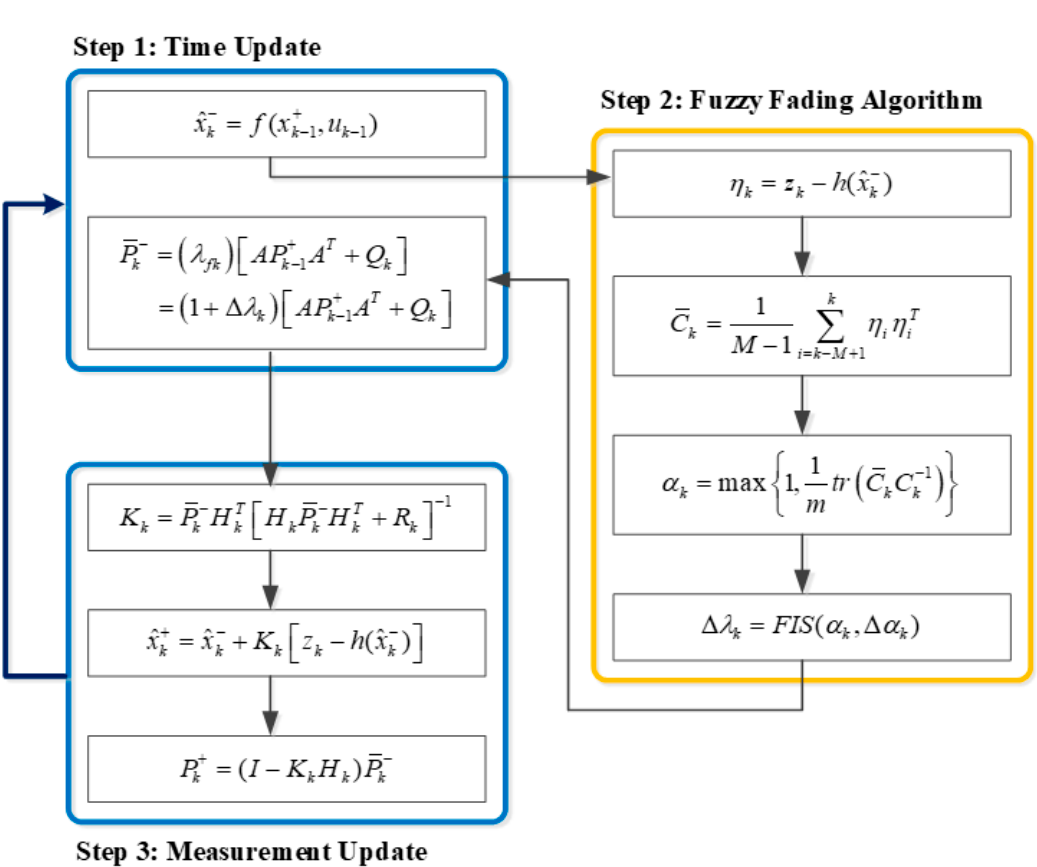
Figure 2. Computation procedure of the proposed adaptive fuzzy fading Kalman filter. Table 1. Fuzzy rules for forgetting factor of the proposed adaptive fuzzy fading Kalman filter.